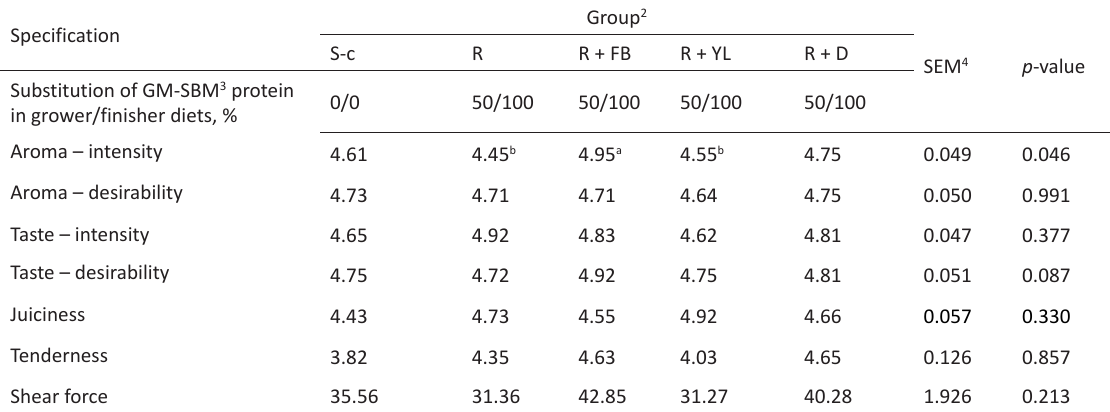
Table 6. Sensory properties (points 1 ) and shear force (N) of the cooked longissimus dorsi muscle in growing-finishing pigs ( )